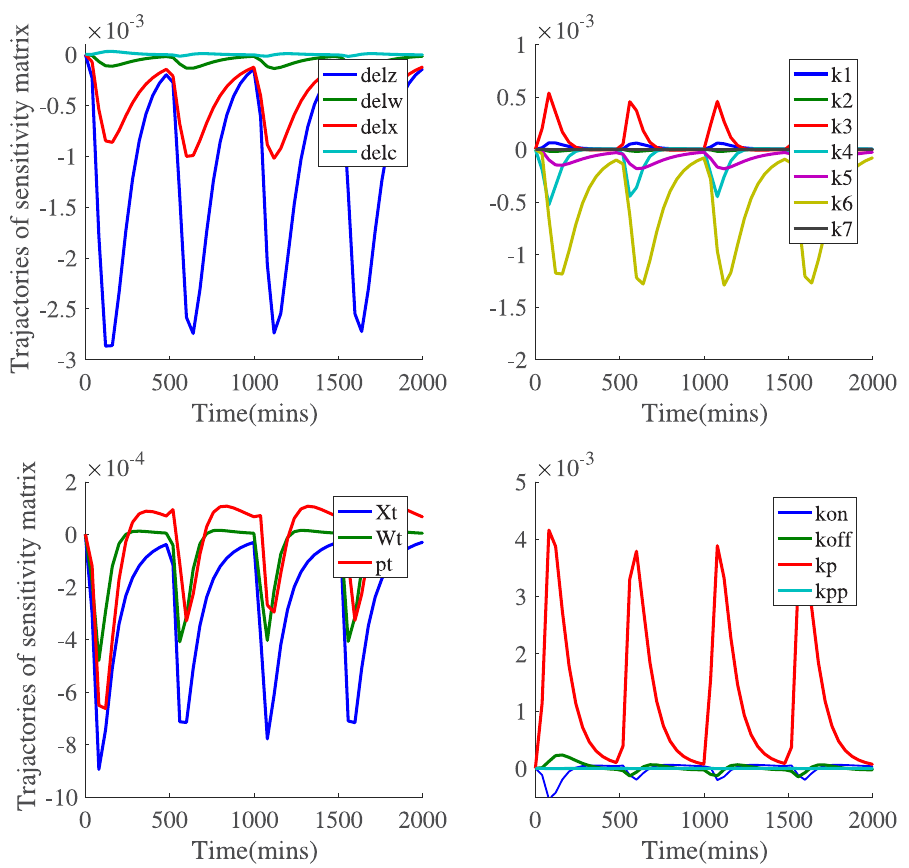
Fig 8. Sensitivity analysis of model parameters for buffered gene network. Among these 23 kinetic parameters, sensitivity matrices of 18 model parameters are plotted to reflect the various levels of influence.